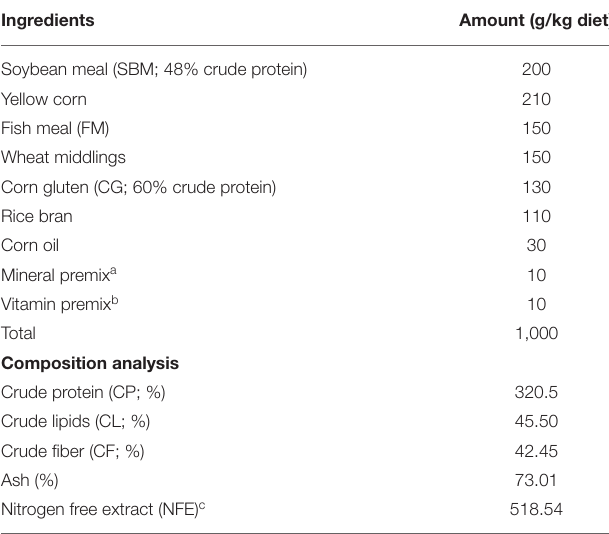
TABLE 1 | Ration constituents (g kg − 1 diet) and proximate composition analysis of the control diet (35, 55) used in the experiment.